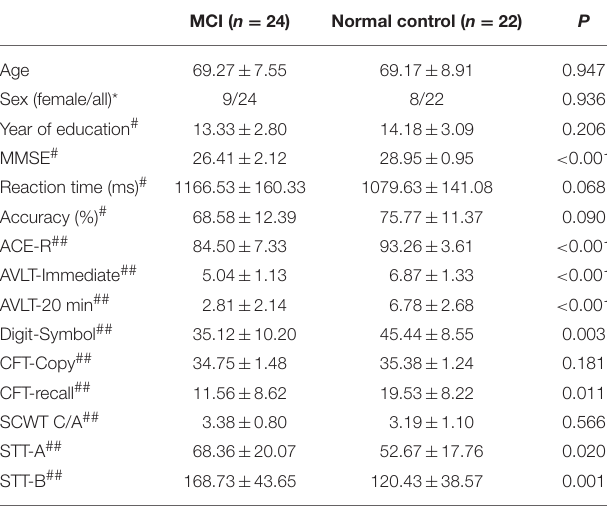
TABLE 1 | Demographic data and task performance (Mean ± Standard Deviation).